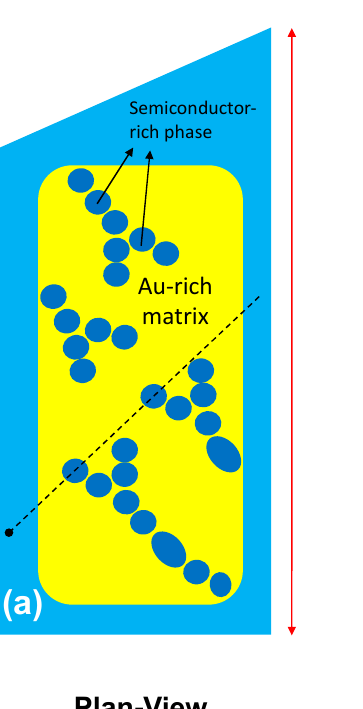
Figure 8. Proposed schematic of the pit formation process: ( a ) plan-view schematic of the sample with a large opening (indicated by a red double arrow) showing the formation of arrays of rods and lamella which are semiconductor-rich phases in the vicinity of the Au-rich matrix. The dashed line indicates the cross-sectional line shown in ( b , c ) for the schematics before and after the SF 6 -based DRIE step, respectively. The solid circle of the line indicates the left-most region in ( b , c ).